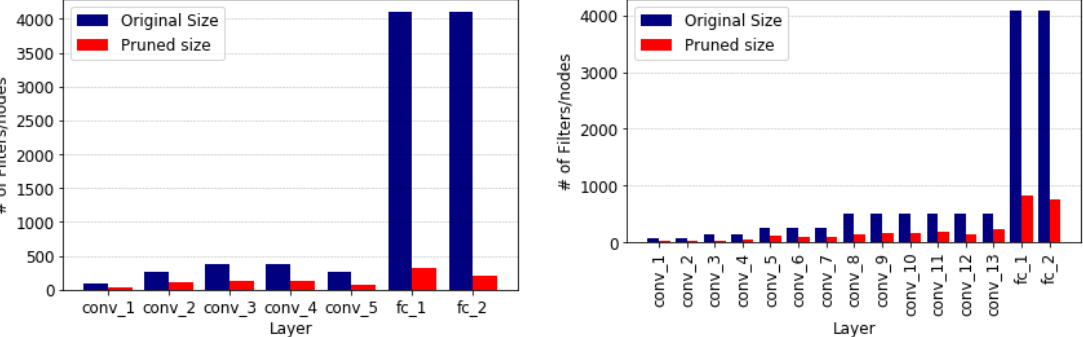
Figure 3. Comparison of layers between original and pruned version of both AlexNet and VGG16 on the MIT67 dataset.